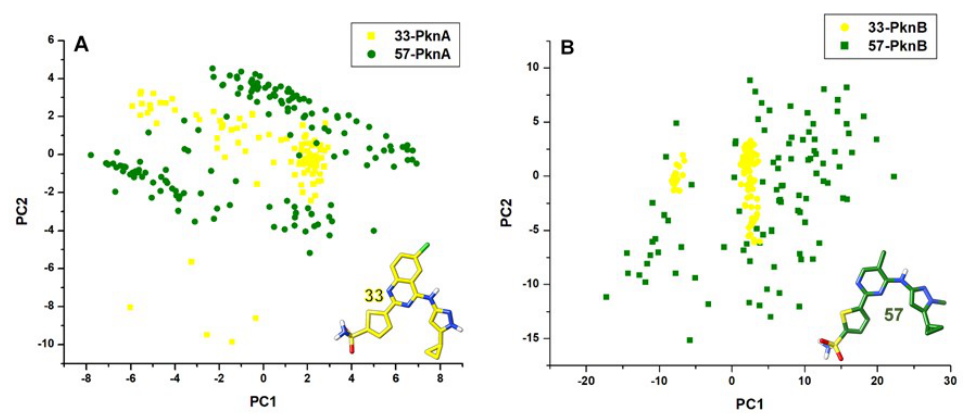
Figure 10. Principal component analyses of the differential motions of compounds 33 and 57 at the nucleotide binding pockets of ( A ) PknA and ( B ) PknB over the simulation period. Depicted in yellow and green colorations are compounds 33 and 57 respectively.